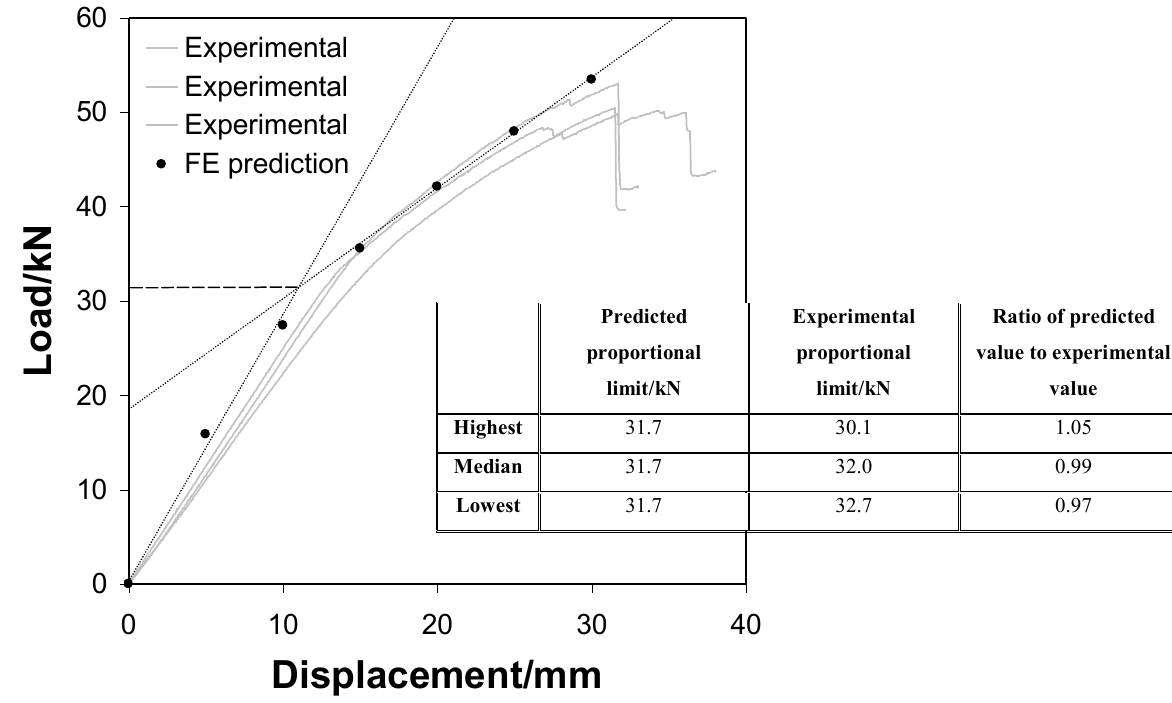
Figure 10. Load-displacement curves for series III tested steel-reinforced LVL samples (in grey) and estimated finite element predictions (black dots). A comparison is made between the predicted and experimental proportional limits.